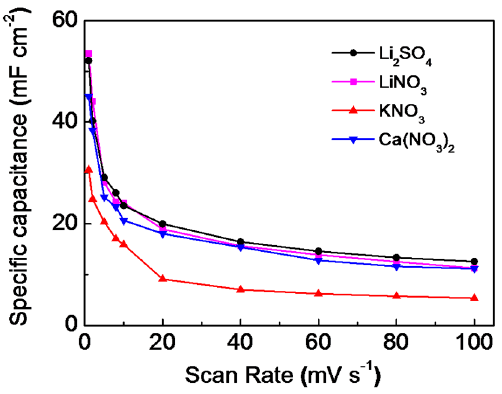
Figure 4. The corresponding variation of the specific capacitances with the scan rate of the Fe 2 O 3 @CC electrode in different electrolytes.